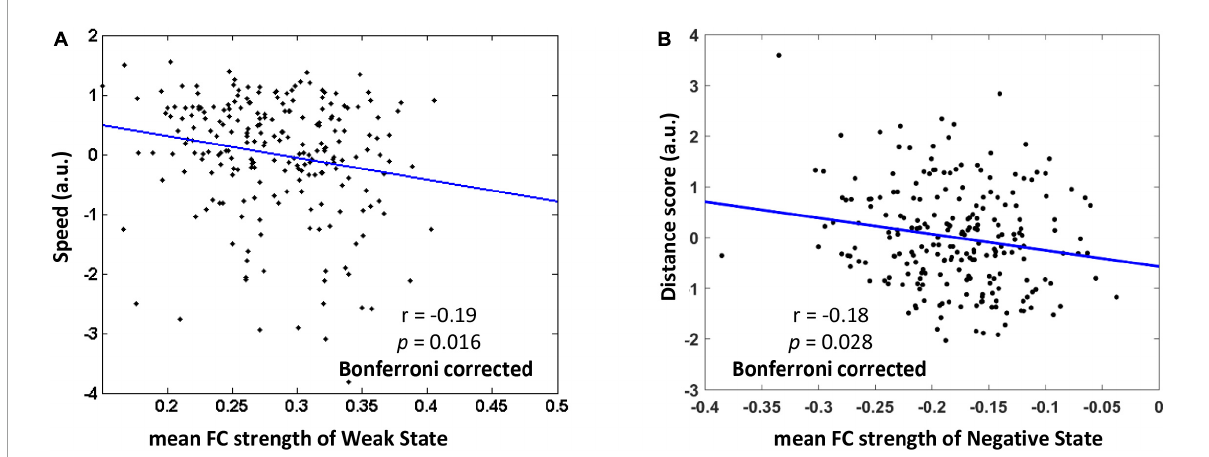
FIGURE4 The relationship between mean functional connectivity (FC) strength of typical FC states and behavioral performance of representing categorial and coordinate spatial relations (Bonferroni correction). (A) Weaker mean FC of Weak State within the ventral subnetwork was related to higher speed in ordinal scene recognition based on representation of categorical spatial relations. (B) Stronger negative FC of Negative State between the ventral and other subnetworks was associated with higher distance scores based on representation of coordinate spatial relations. The speed score and distance score were